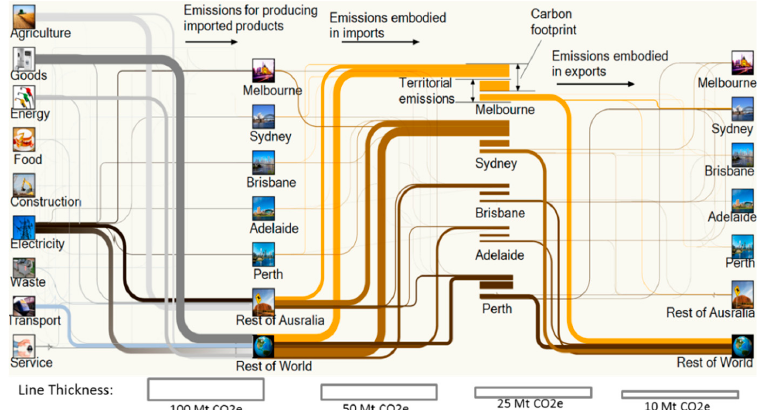
Figure 3. Flows of GHG emissions embodied in the final demand of five Australian cities (note: the full graph including a breakdown of emissions embodied in exports (EEE) by sector is shown in the Supplementary Data).